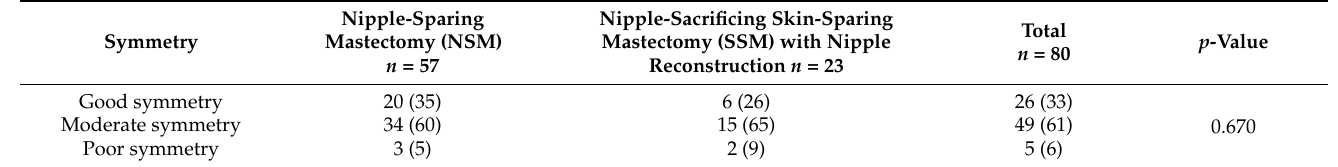
Table 3. Overall nipple symmetry comparing NSM to